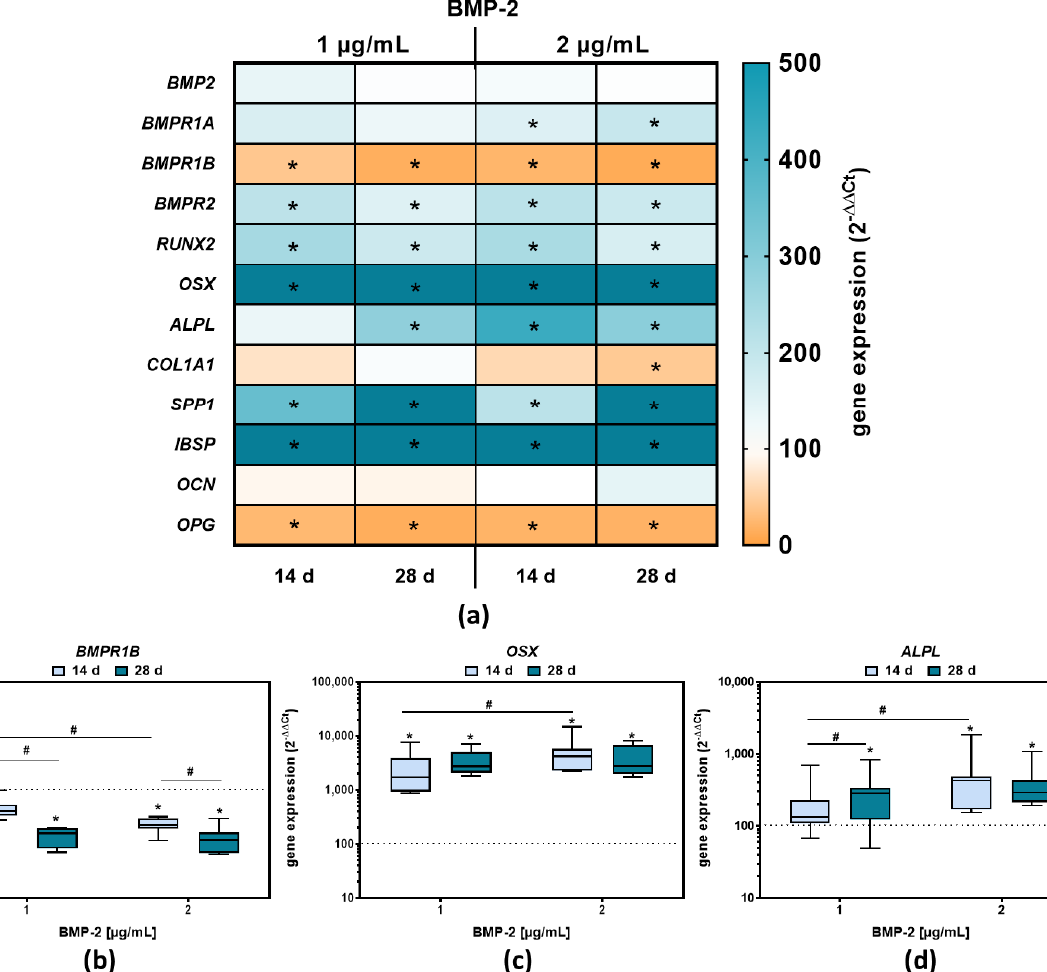
Figure 2. Gene expression results following BMP-2 exposure to 1 or 2 µg/mL after 14 or 28 days. ( a ) Gene expression results depicted as Heatmap. ( b – d ) The data are depicted as 2 ( −∆∆Ct) values with * p < 0.05 compared to the control and # p < 0.05 compared to different time points or concentrations using two-way ANOVA with Bonferroni’s multiple comparisons test (n ≥ 7).